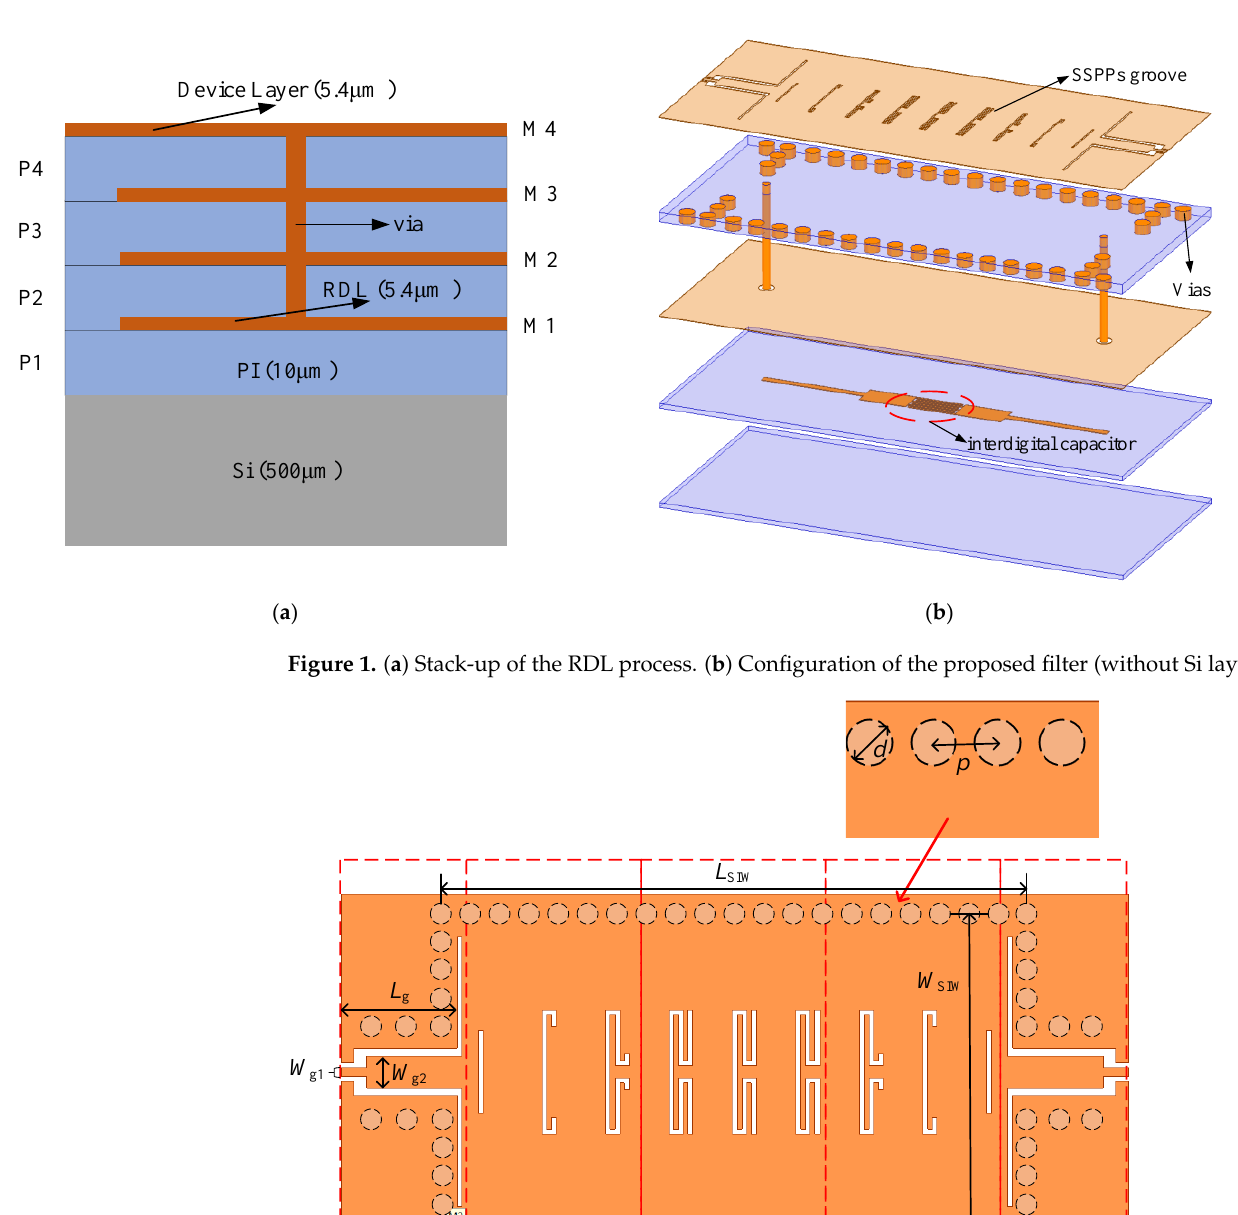
where W SIW and L SIW are the width and length of the equivalent rectangular waveguide, calculated